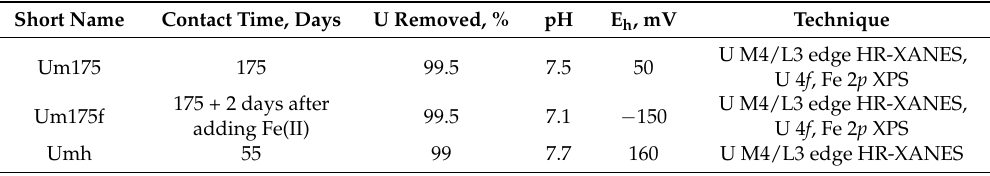
Table 4. Name of samples, U contact time, U percentage removed by magnetite (Um) and maghemite (Umh) for suspensions with [U] = 3 × 10 − 5 M and [NaCl] = 0.01 M, pH, E h values and applied spectroscopy